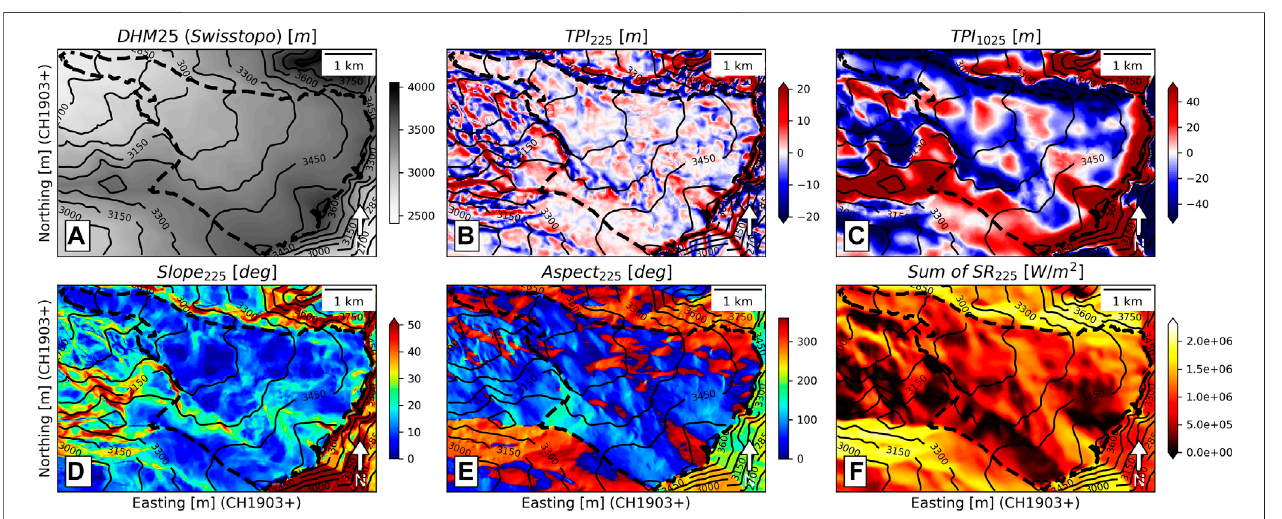
Frontiers in Earth Science |